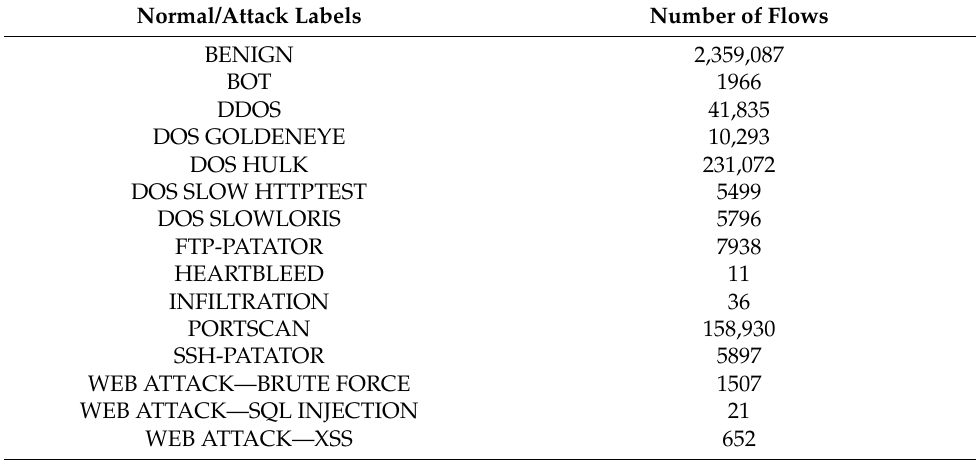
Table 2. Labeled features in